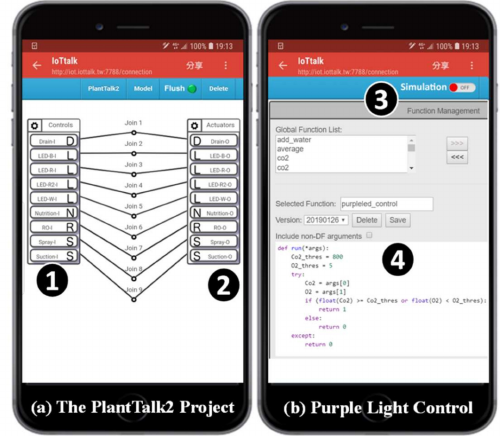
Figure 6. PlantTalk project 2 and the function management window.